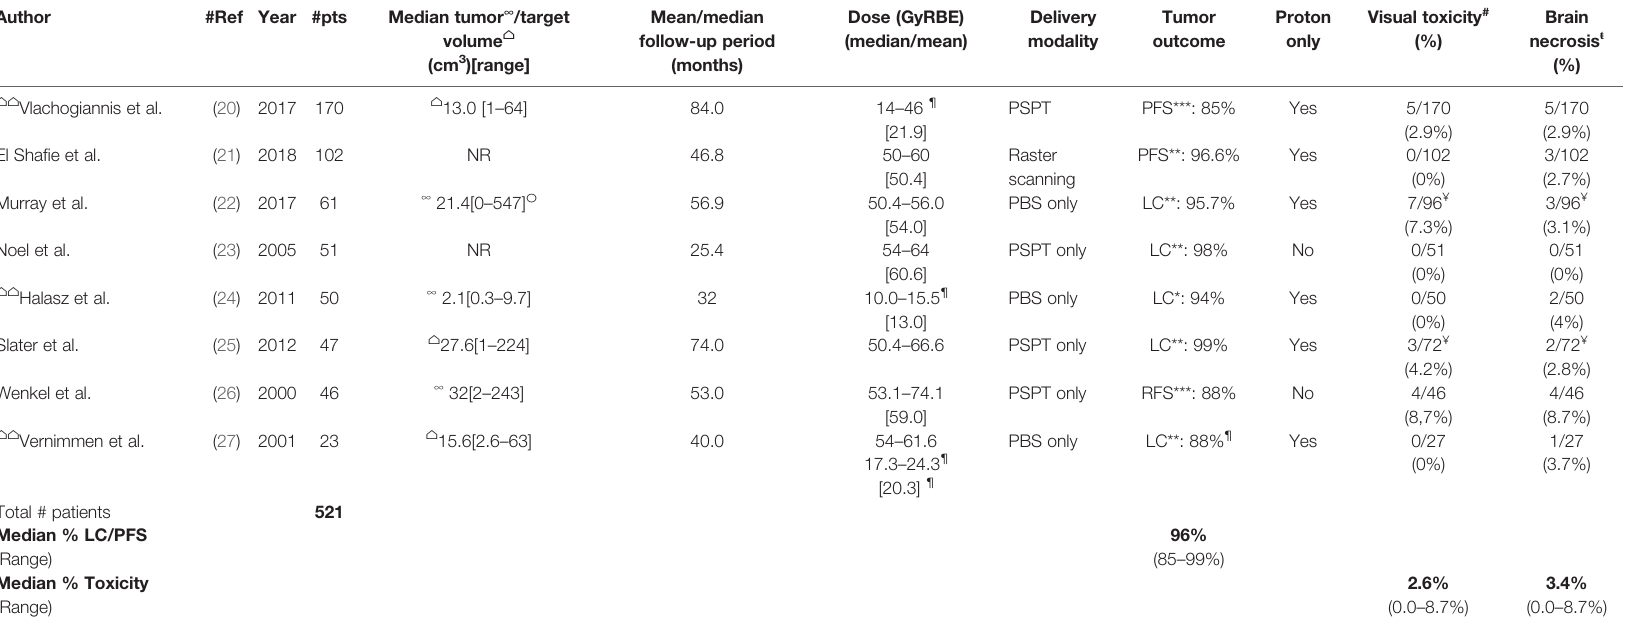
TABLE 1 | Pencil beam scanning or passive-scattering proton therapy delivered to presumed or histologically-proven WHO grade I tumors.